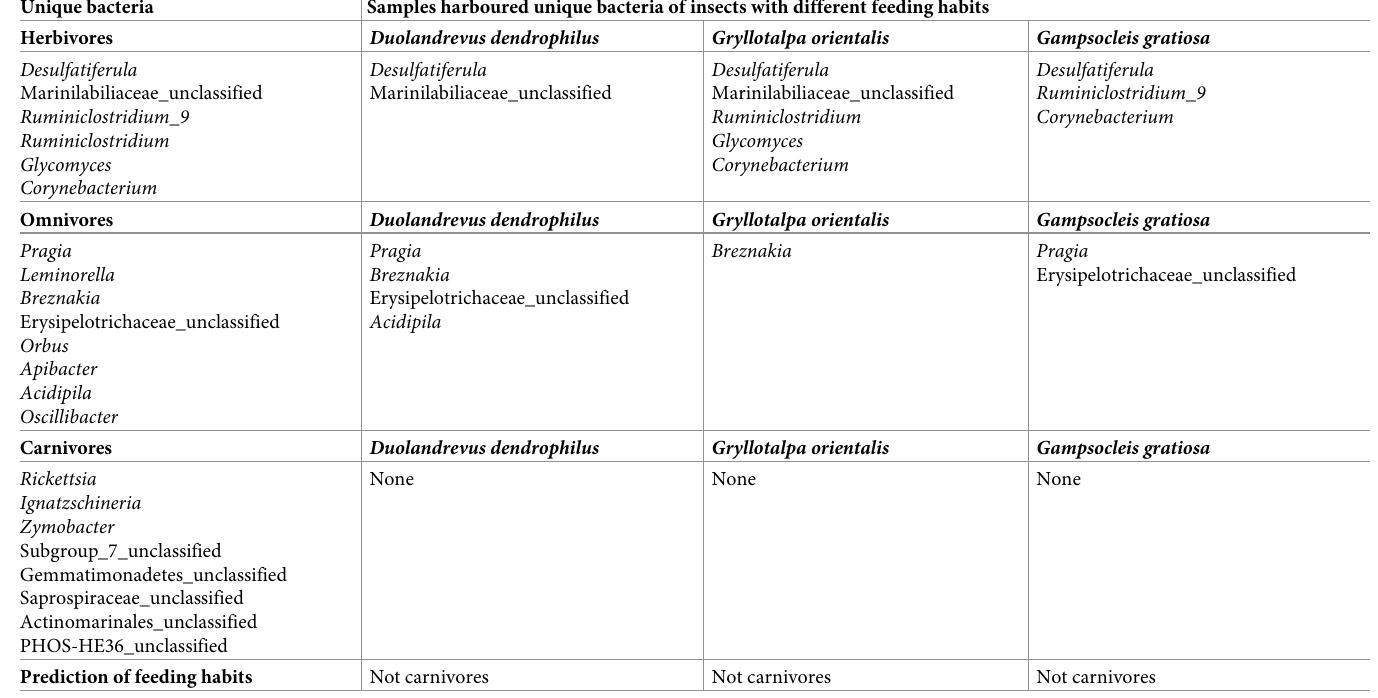
Table 5. Assess dietary pattern using unique bacteria of insects with different feeding